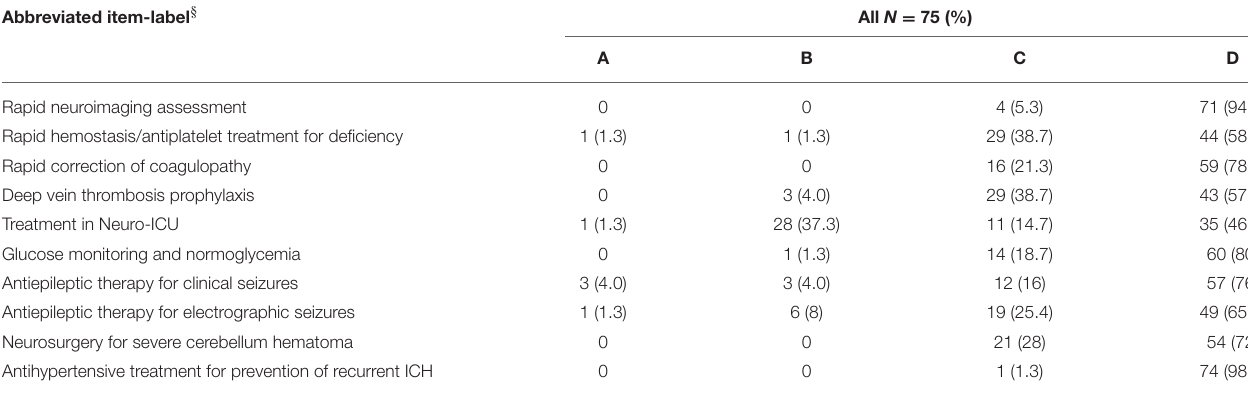
TABLE 5 | Results of the 10-item questionnaire to assess the perceived as important of the AHA guideline recommendations*.